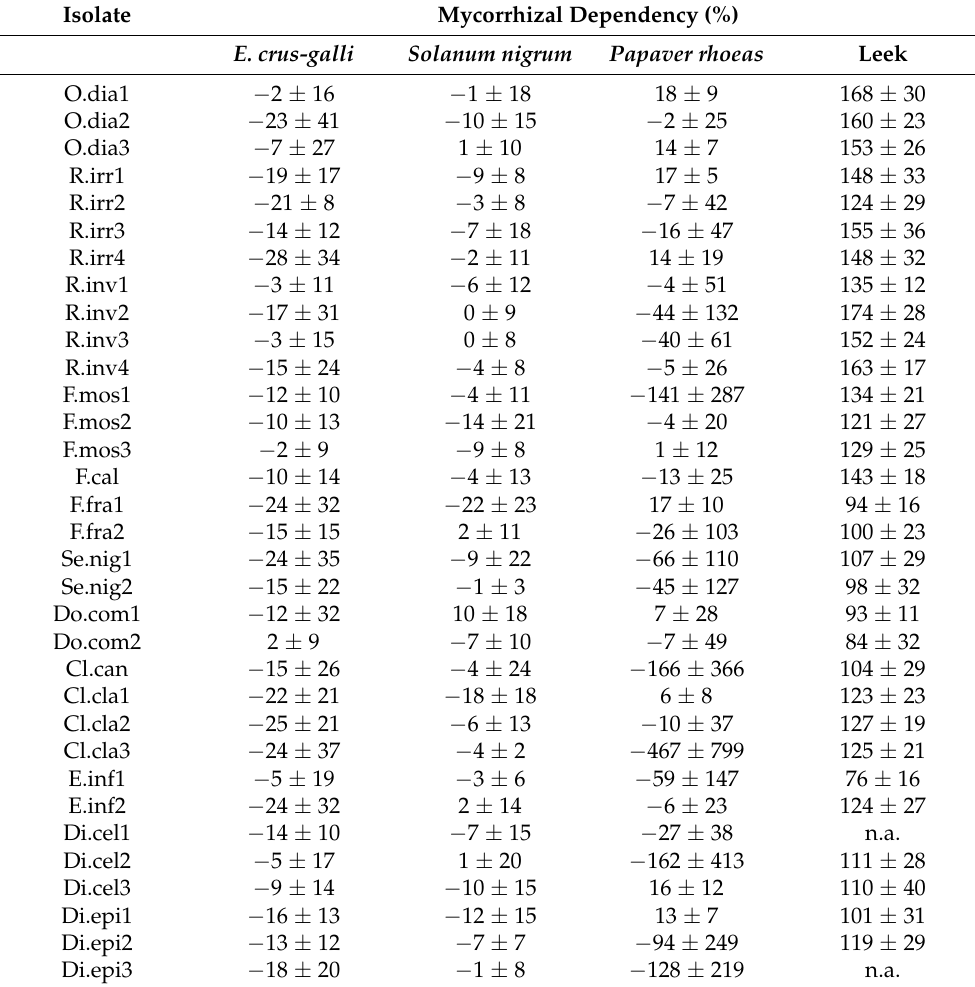
Table 2. Mycorrrhizal dependency (in %) of the weeds E. crus-galli , S. nigrum and P. rhoeas in comparison to leek plants adapted with permission from a study from Säle, et al. [21]. Data show means of six replicates ± SD; n.a. = not